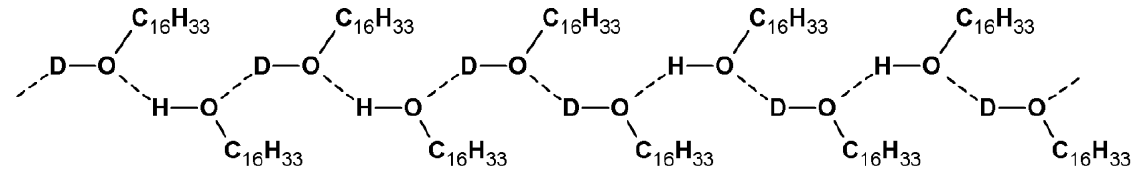
Figure 3. Cetyl alcohol isotopically diluted with deuterons.